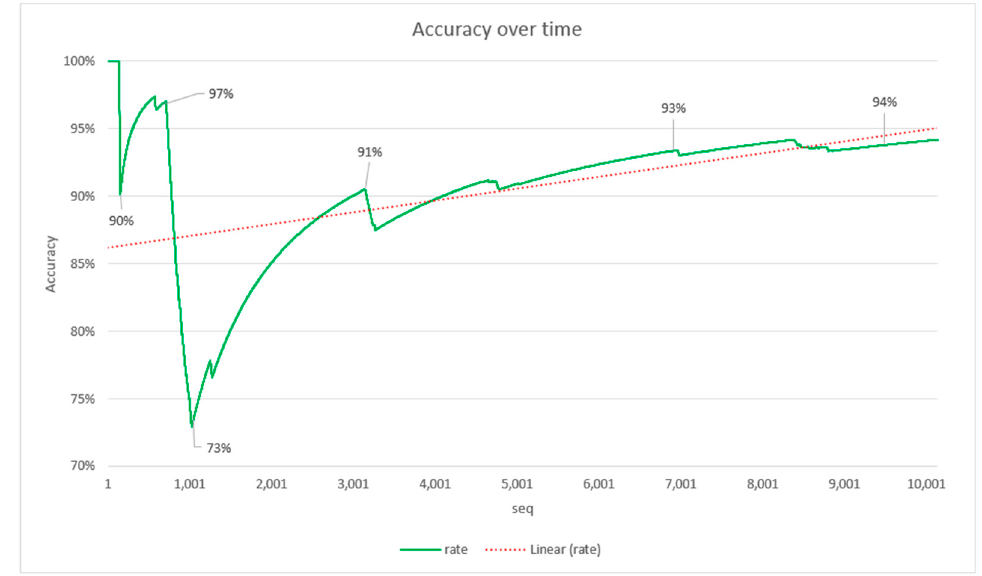
Figure 10. Accuracy over